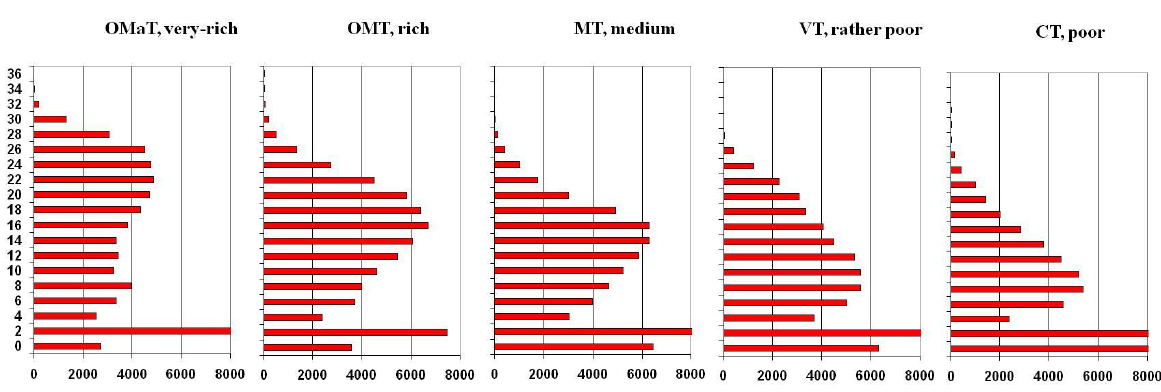
Figure 2. First and only pulse (fo) height distributions in different fertility classes by Cajander [1].